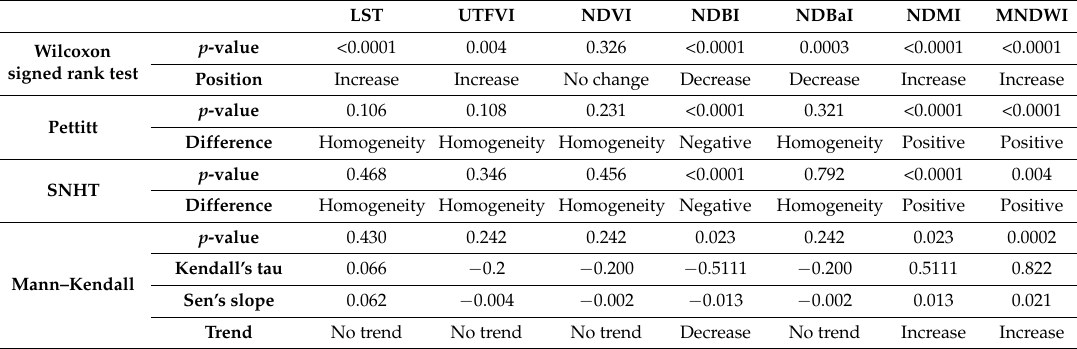
Table 9. Tests results for the Garibaldi Street on selected dates for median LST and spectral indices.